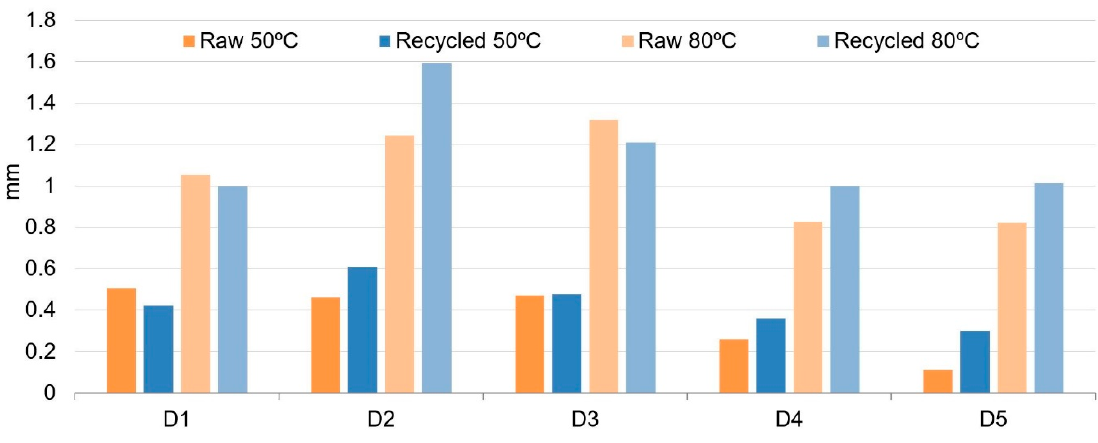
Figure 6. Dimension differences between heated samples and non-heated samples without heating after stabilization at room temperature.